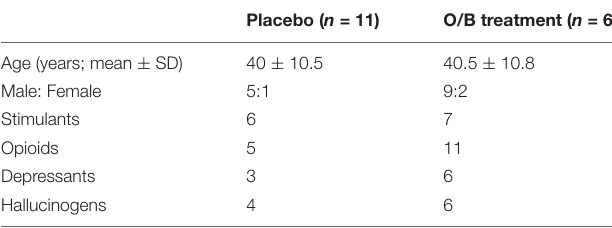
baseline that included assessment of their basic cognitive skills. TABLE 1 | Demographic and clinical characteristics of the study